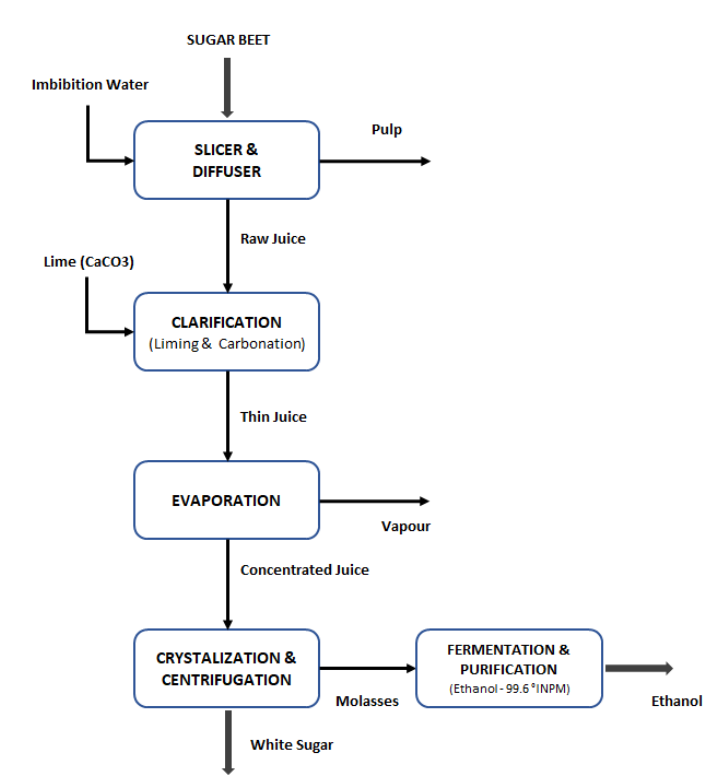
Figure 4. Traditional sugar beet processing to produce ethanol and white sugar.